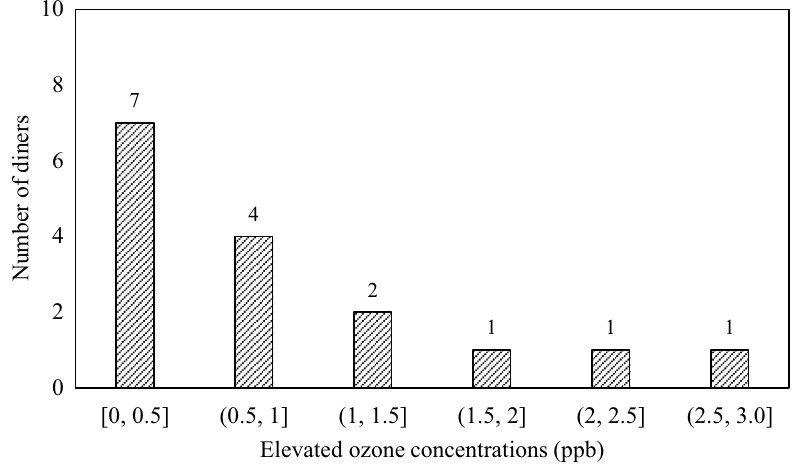
Figure 9. Statistical distribution of the number of diners with the elevated ozone concentration in the breathing zones among the 16